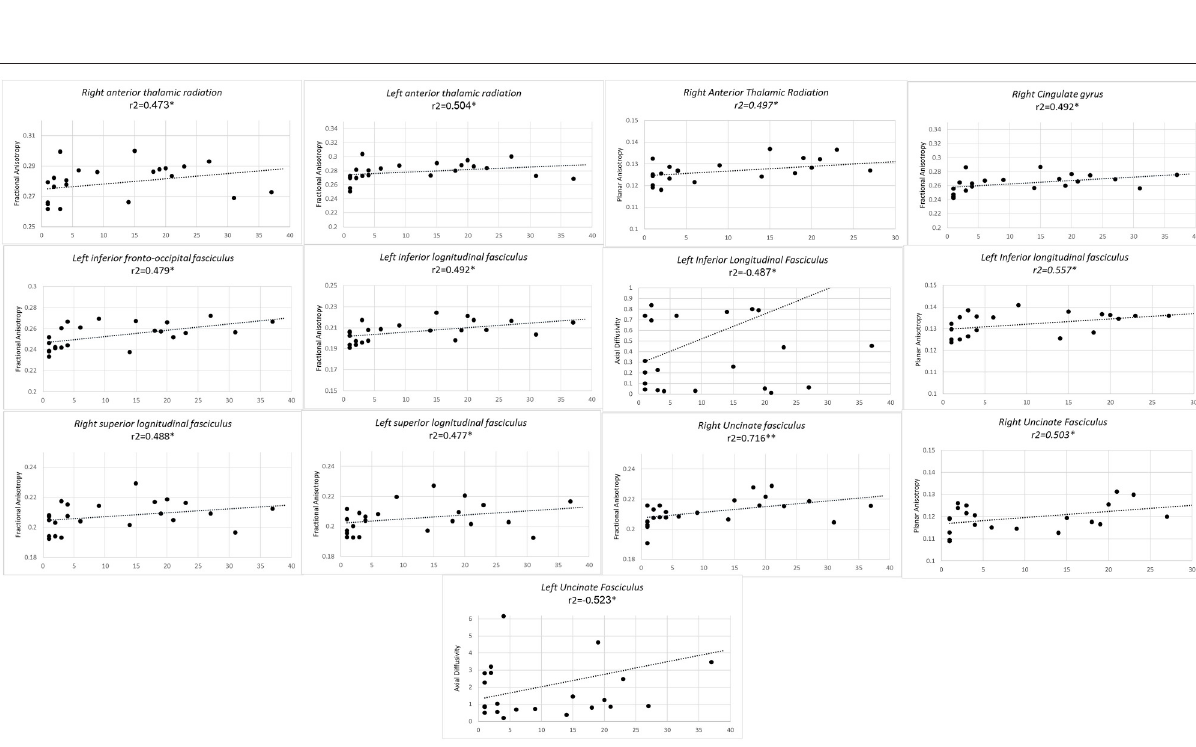
Frontiers in Neuroscience |